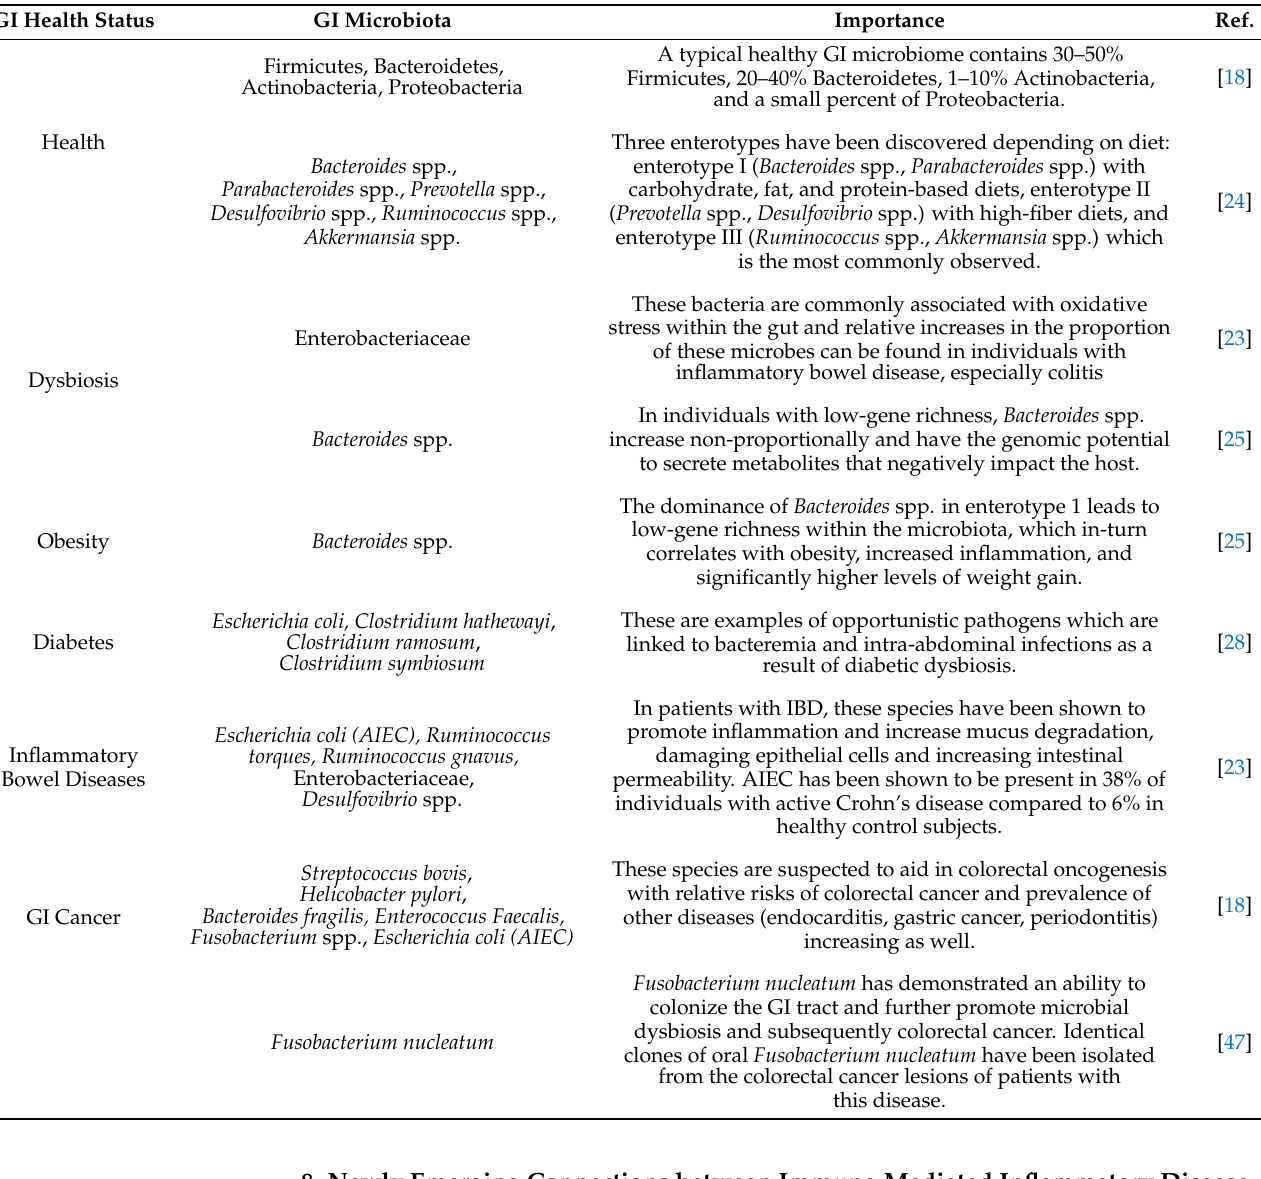
Table 2. Importance of specific gastrointestinal (GI) microorganisms according to GI health status. GI Health